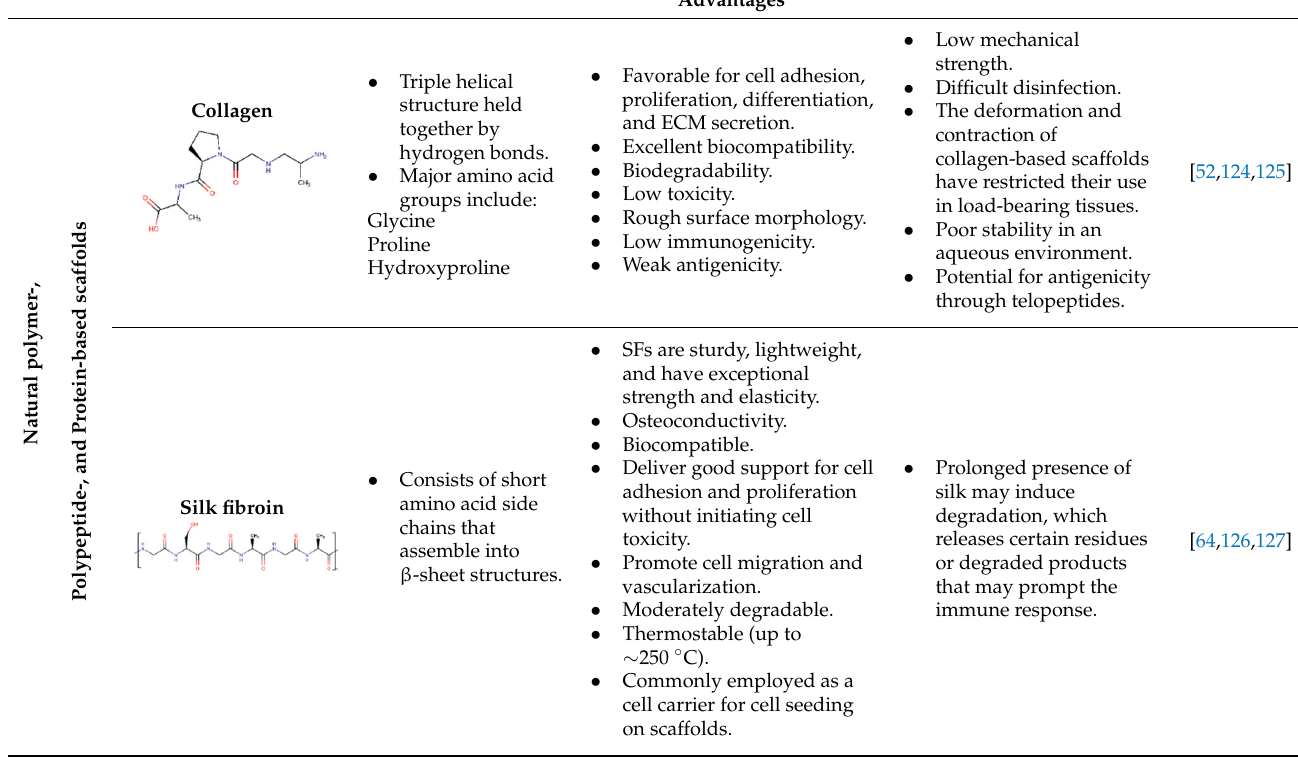
Table 1. Comprehensive analysis of naturally occurring and synthetic biopolymers along with their advantages and disadvantages. Polymer